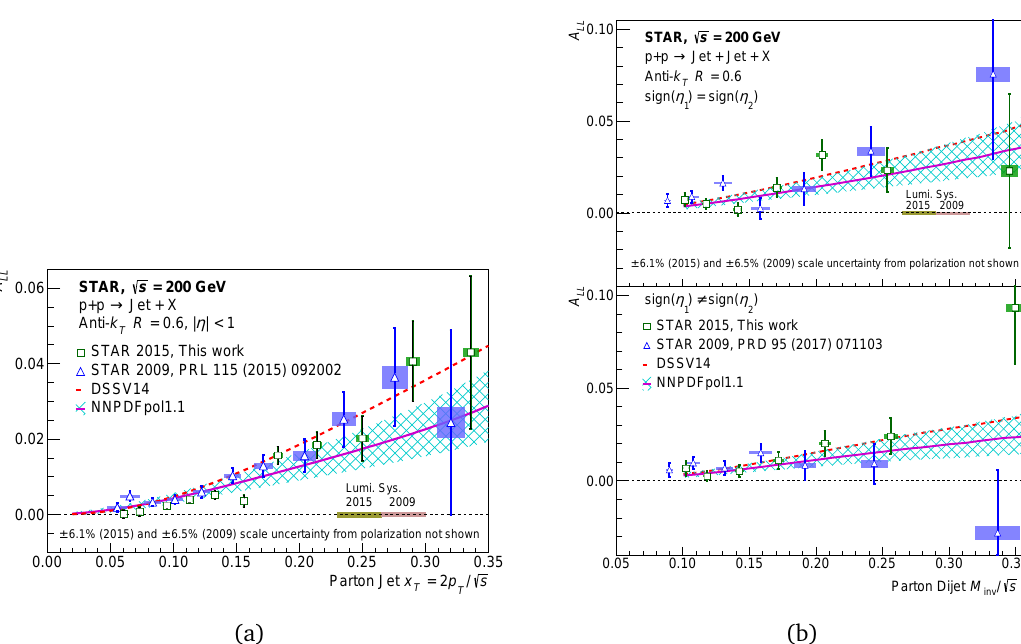
Figure 1: (a) A for inclusive jets with | η | < 1.0 versus x at the parton level. LL T The square markers show the 2015 data from [ 12 ] , whereas the triangle markers show the 2009 data from [ 1 ] . The error-bars show the size of the statistical uncer- tainties, whereas the boxes indicate the size of the systematic uncertainties. The yellow and pink bands on the horizontal axis represent the common relative lumi- nosity uncertainty. The curves show the expected A values for the DSSV14 [ 2 ] and (cid:112) LL / s for dijets with the NNPDFpol1.1 [ 3 ] parton distributions. (b) A versus M LL inv ) = sign ( η ) (top) and sign ( η ) (cid:54) = sign ( η ) (bottom) event topologies. The sign ( η 1 2 1 2 square markers show the 2015 data from [ 12 ] , whereas the triangle markers show the 2009 data from [ 4 ] . The results are compared to theoretical predictions for dijets from DSSV14 [ 2 ] and NNPDFpol1.1 [ 3 ]